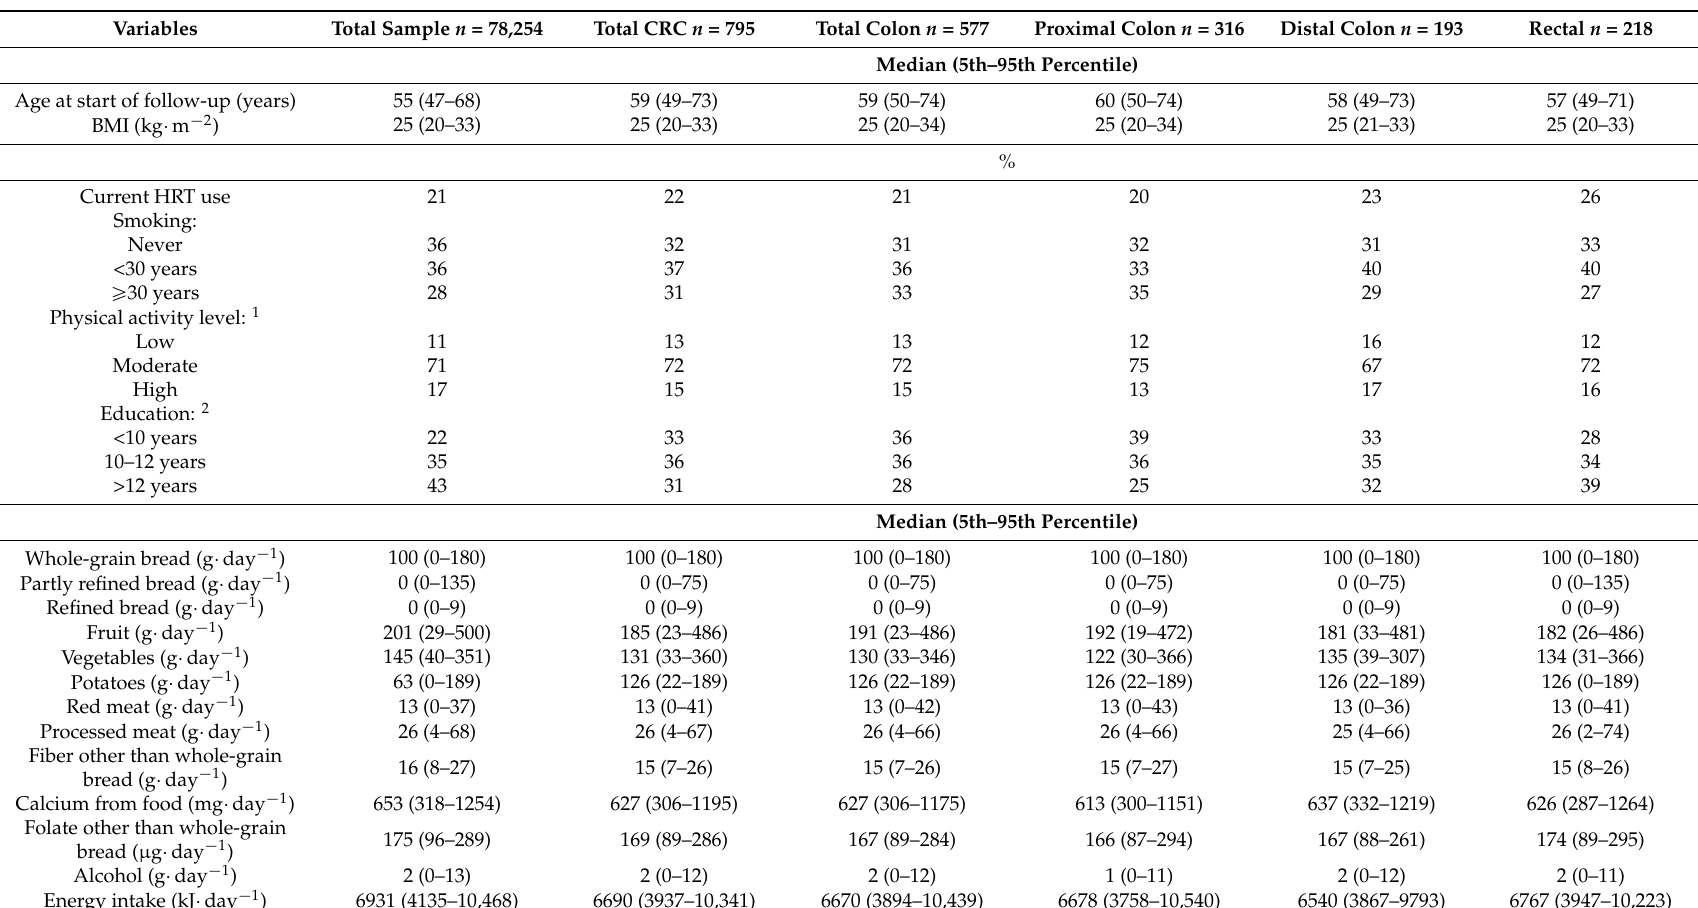
Table 2. Baseline characteristics (2002–2006) of the study sample and colorectal cancer (CRC) cases by total CRC and colorectal subsites (Norwegian Women and Cancer Study), n =